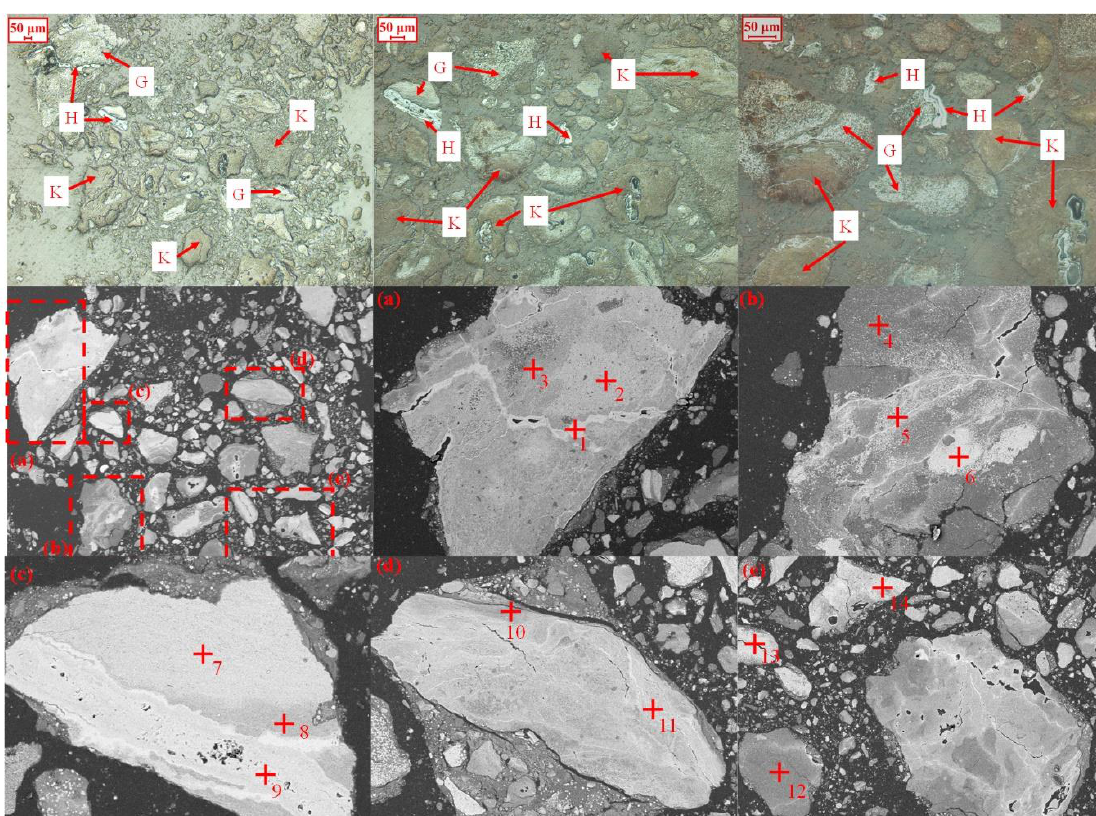
Figure 1. XRD di ff raction pattern of HAIO. Figure 1. XRD diffraction pattern of HAIO. Figure 1. XRD diffraction pattern of HAIO.